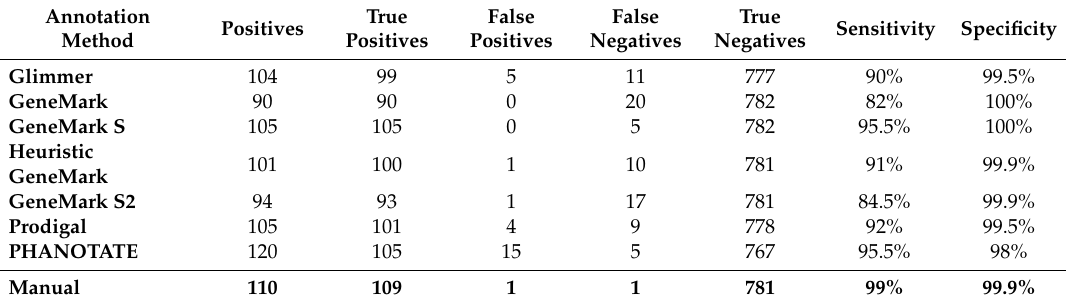
Table 2. Results of gene identification in the genome of mycobacteriophage Patience. Host-trained GeneMark.hmm is omitted due to its anomalous results for this